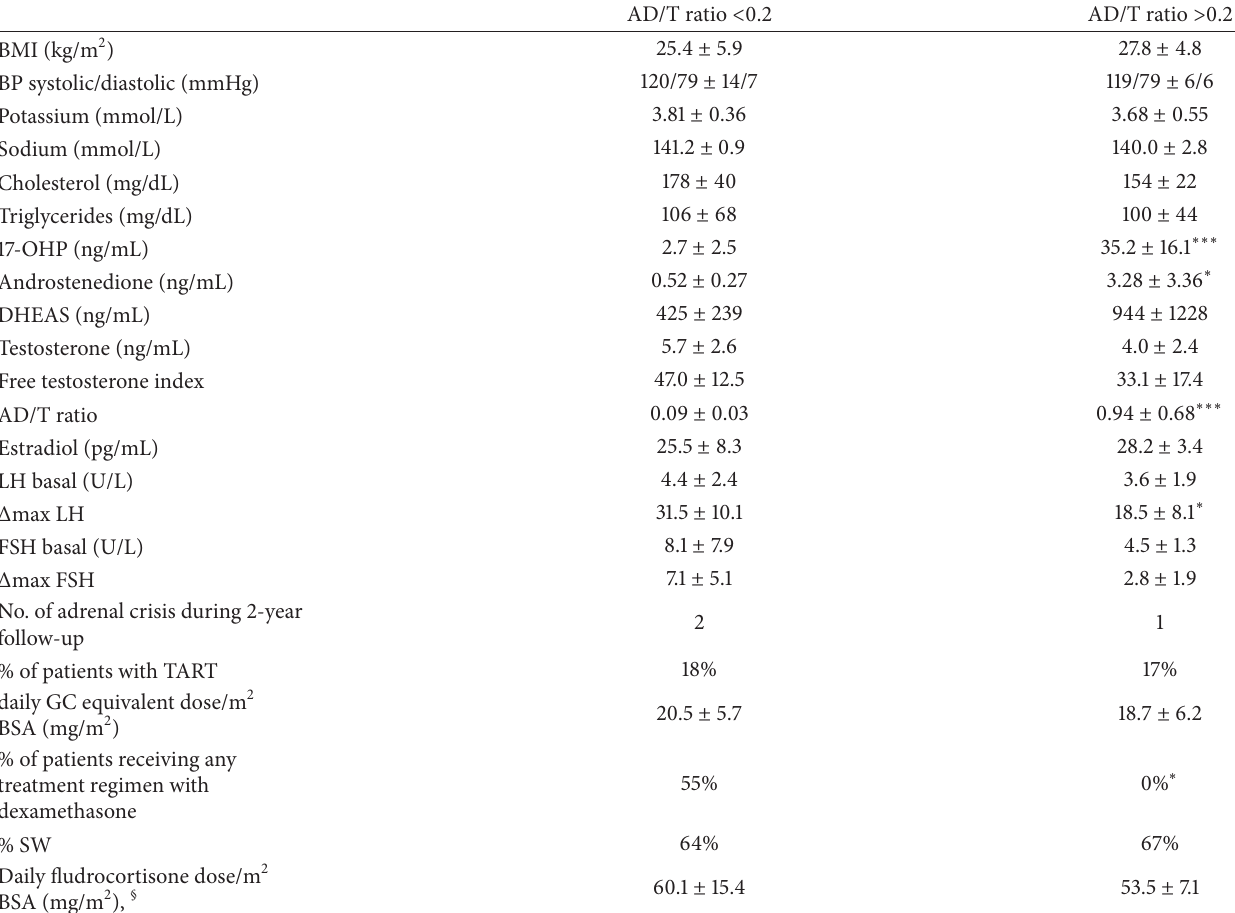
Table 3: Biochemical and hormonal parameters in male patients with 21-OHD depending on AD/T ratio at study start